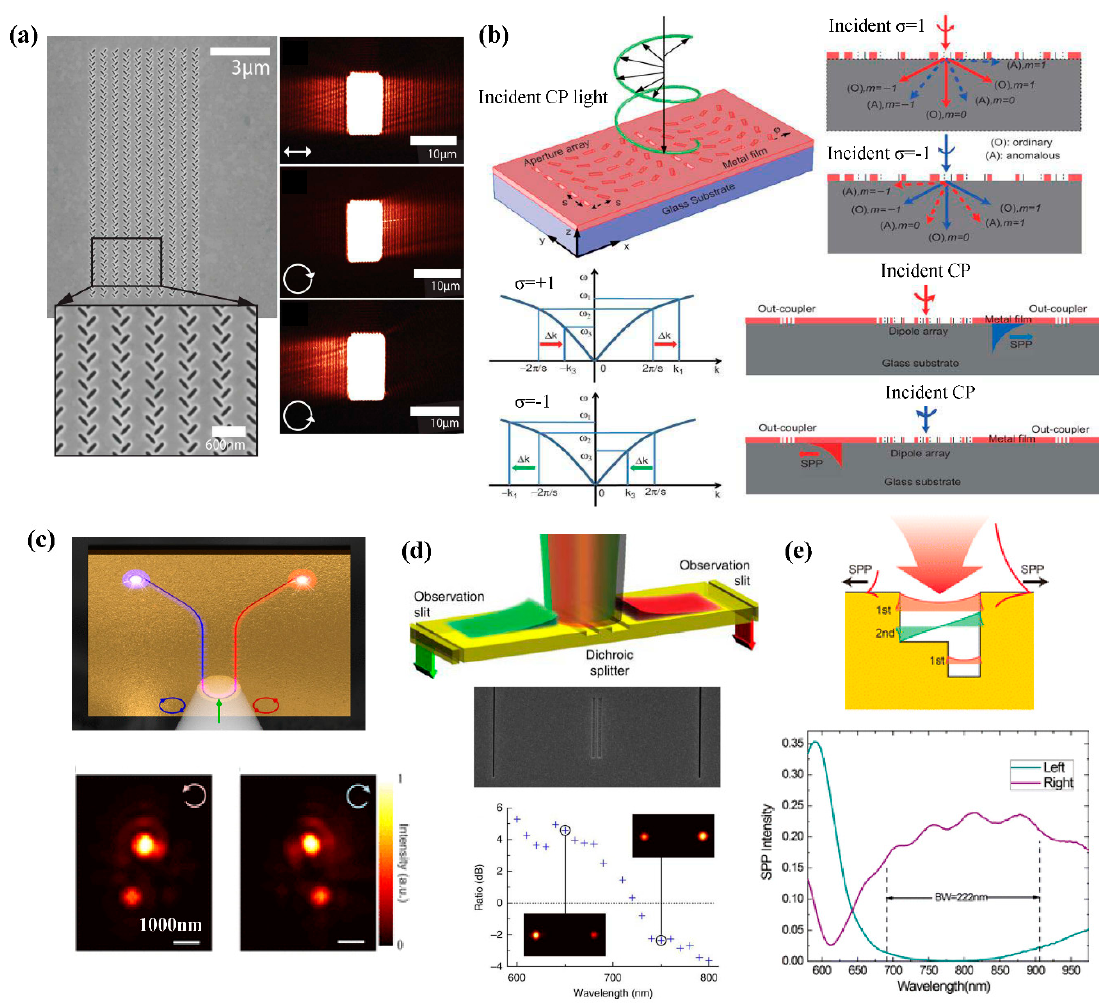
Figure 1. ( a ) Polarization controlled directional excitation of surface plasmon polaritons (SPPs) [48]; ( b ) Directional SPP excitation with interfacial phase discontinuity [49]; ( c ) Directing SPP flows based on spin and orbit angular momentum interaction [50]; ( d ) Wavelength dependent directional SPP excitation [79]; ( e ) Broadband directional SPP excitation with a single compact antenna [80].